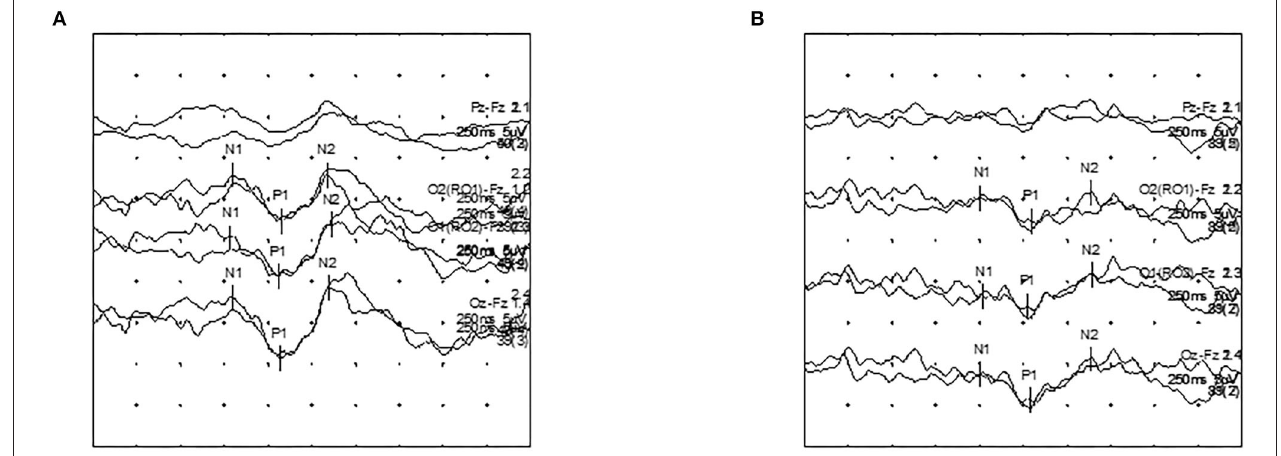
TABLE 3 | Receiver operating characteristic curve analysis of visual functions to discriminate between First-ever ON and Controls. AUC (95% CI ) p- value Cut-off value Sensitivity (%)